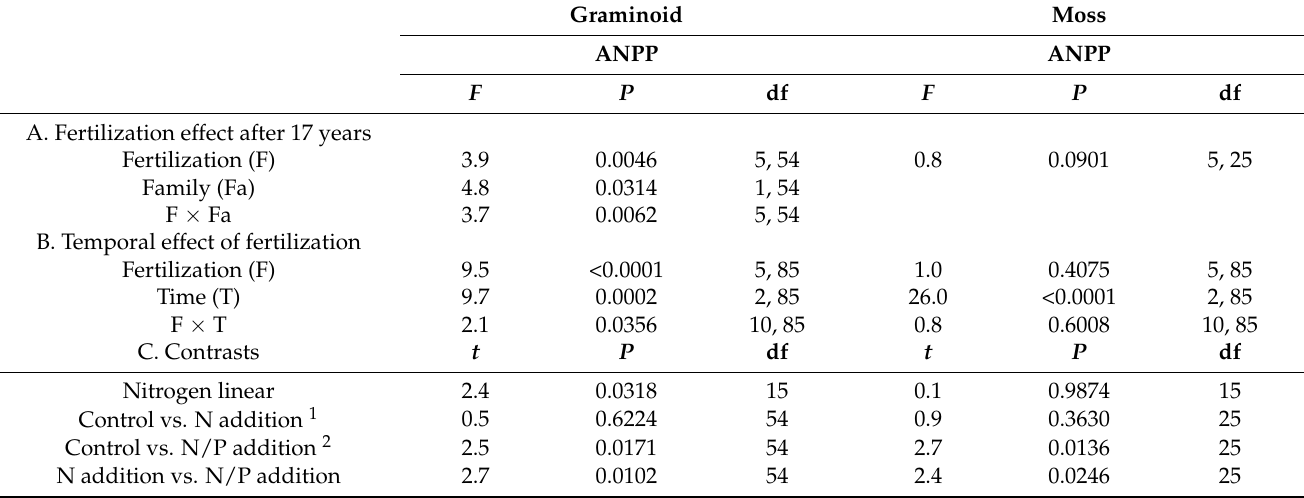
Table 2. Results of linear mixed models evaluating the effects of (A) fertilization after 17 years, graminoid family ( Cyperaceae , Poaceae ) and their interaction, and (B) fertilization, time after initiation of the experiment (2, 5 and 17 years) and their interaction on the aboveground net primary productivity (ANPP) of graminoid plants and mosses in the tundra wetlands of Bylot Island, Nunavut. (C) A priori contrasts were also applied on fertilization effects after 17 years. Graminoid Moss ANPP